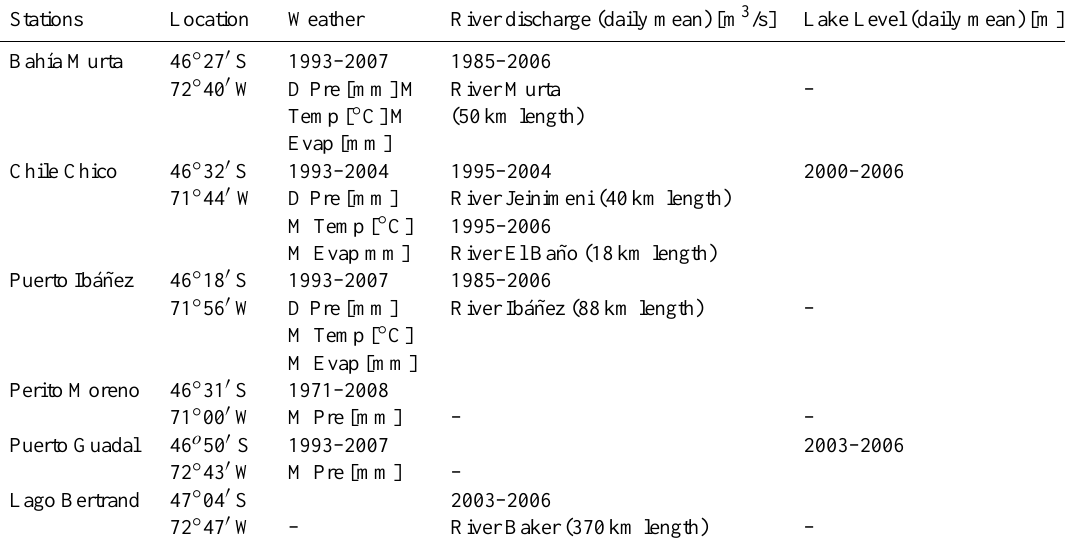
Puerto Ib´a˜nez